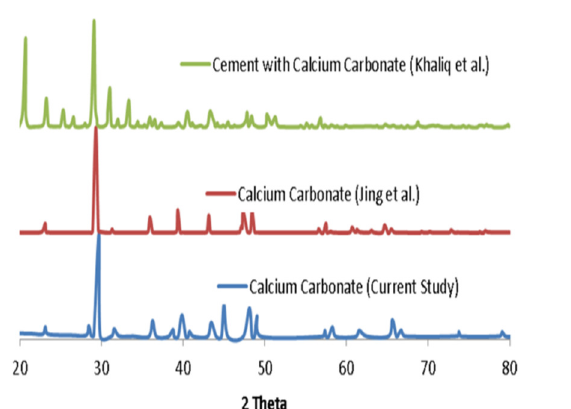
Fig. 5: XRD Pattern of Bacterial By-Product Fig. 6: Curing Effect of Samples with and Without